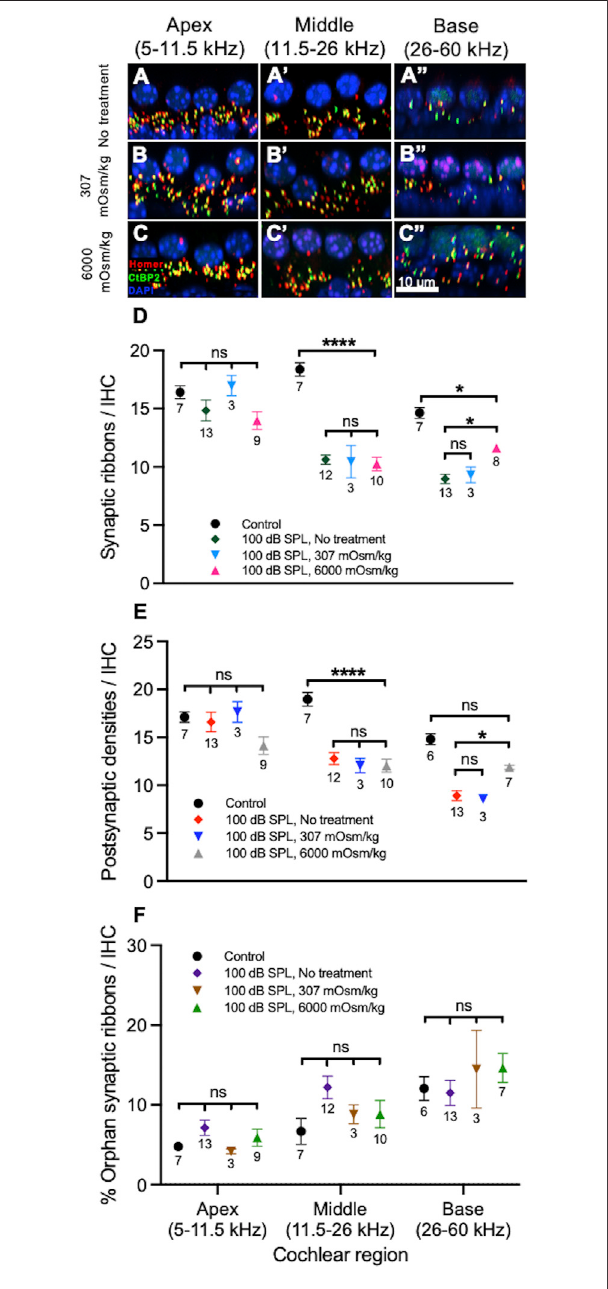
FIGURE6| Osmotictreatmentpartiallyrescuessynapselossafter2 hof 100 decibel (dB) sound pressure level (SPL) noise exposure. (A – C) Representative sections from the organ of Corti of mice 7 days after 100 dB SPL noise exposure displaying 4 inner hair cell (IHC) nuclei and associated ribbons as well as postsynaptic densities (PSDs). Immunolabeling was performed to visualize IHC ribbons (CtBP2, green), PSDs (Homer, red) and nuclei (DAPI, blue). Right ears received no treatment (A) , while left ears received either normotonic saline (307 mOsm/kg) (B) or hypertonic saline (6,000 mOsm/kg) application tothemiddleearafternoiseexposure (C) .More ribbons and PSDs per IHC are present in the cochlear base of ears treated with hypertonic saline (6,000 mOsm/kg) compared with ears treated with normotonic saline (307 mOsm/kg) and untreated ears (no treatment). (D)